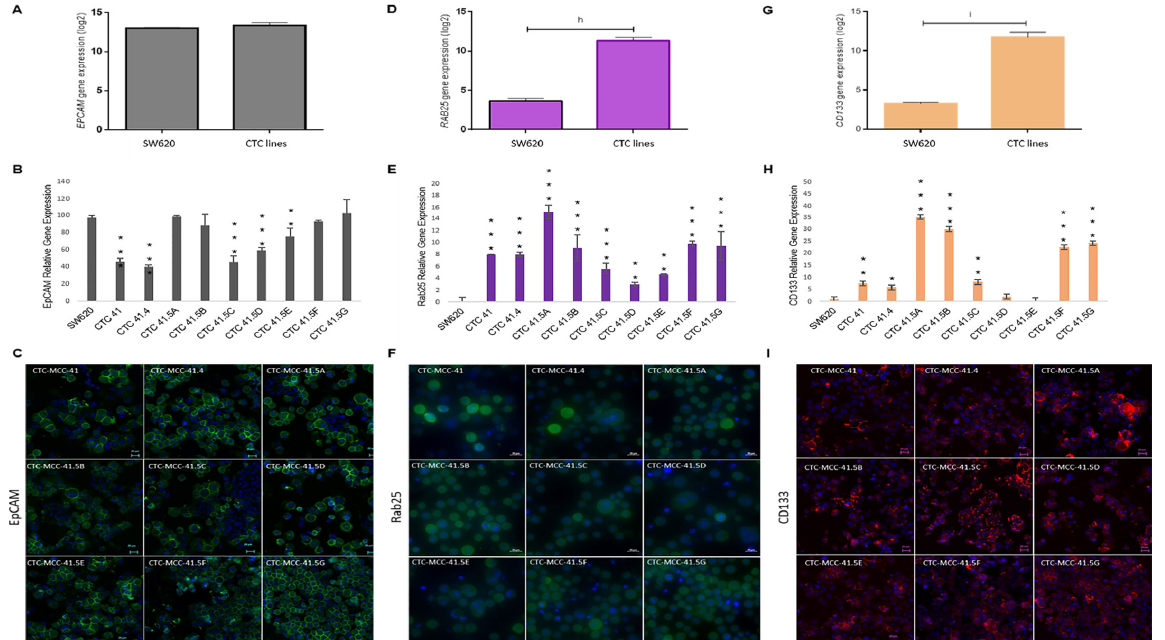
Figure 4. The GRHL2 direct and indirect targets EpCAM, RAB25, and CD133 are differentially expressed in each CTC line. ( A ) Comparison of EPCAM expression in CTC lines and SW620 cells (microarray data). ( B ) Relative EPCAM gene expression in each CTC line and in SW620 cells. ( C ) EpCAM protein expression in the nine CTC lines by immunofluorescence analysis. ( D ) Comparison of RAB25 expression in CTC lines and SW620 cells (microarray data). ( E ) RAB25 gene expression profile in each CTC line and in SW620 cells. ( F ) Immunofluorescence staining of RAB25 protein in the nine CTC cell lines. ( G ) Comparison of CD133 in CTC lines and SW620 cells (microarray data). ( H ) CD133 expression pattern in CTC lines and SW620 cells. ( I ) CD133 protein detection by immunofluorescence analysis. The scale bars denote 20 µm. h: p -value = 1.57 × 10 −23 ; i: p -value = 1.34 × 10 −18 . All the RT-qPCR results were normalized to the B2M expression level in each sample; * p < 0.05, ** p < 0.01, *** p < 0.001 compared with SW620 cells.